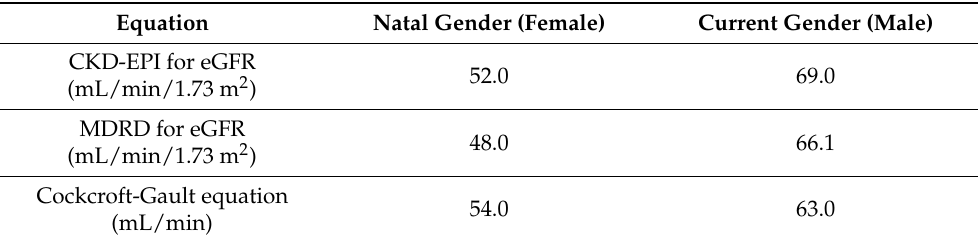
Table 1. Estimated eGFR according to gender for both